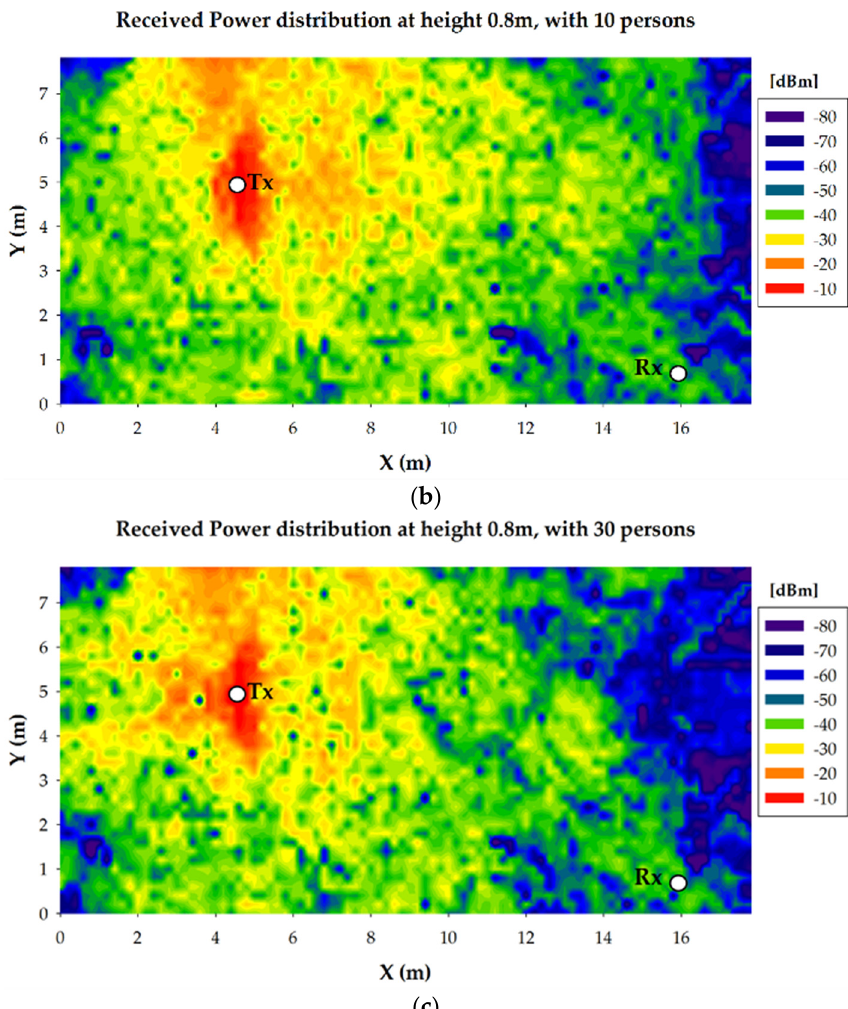
Figure 11. Estimated received power level distribution plane at height 0.8 m for the transmitter on the Judoka’s chest, ( a ) without more persons in the scenario; ( b ) with 10 persons and ( c ) with 30 persons.